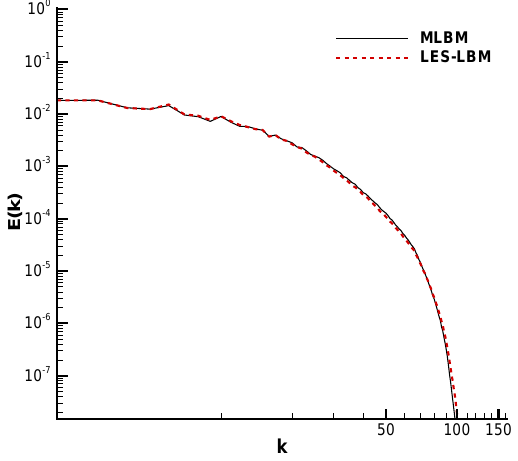
Fig. 5 Comparison of energy spectrum between MLBM and LES-LBM for Re λ = 225 at t =